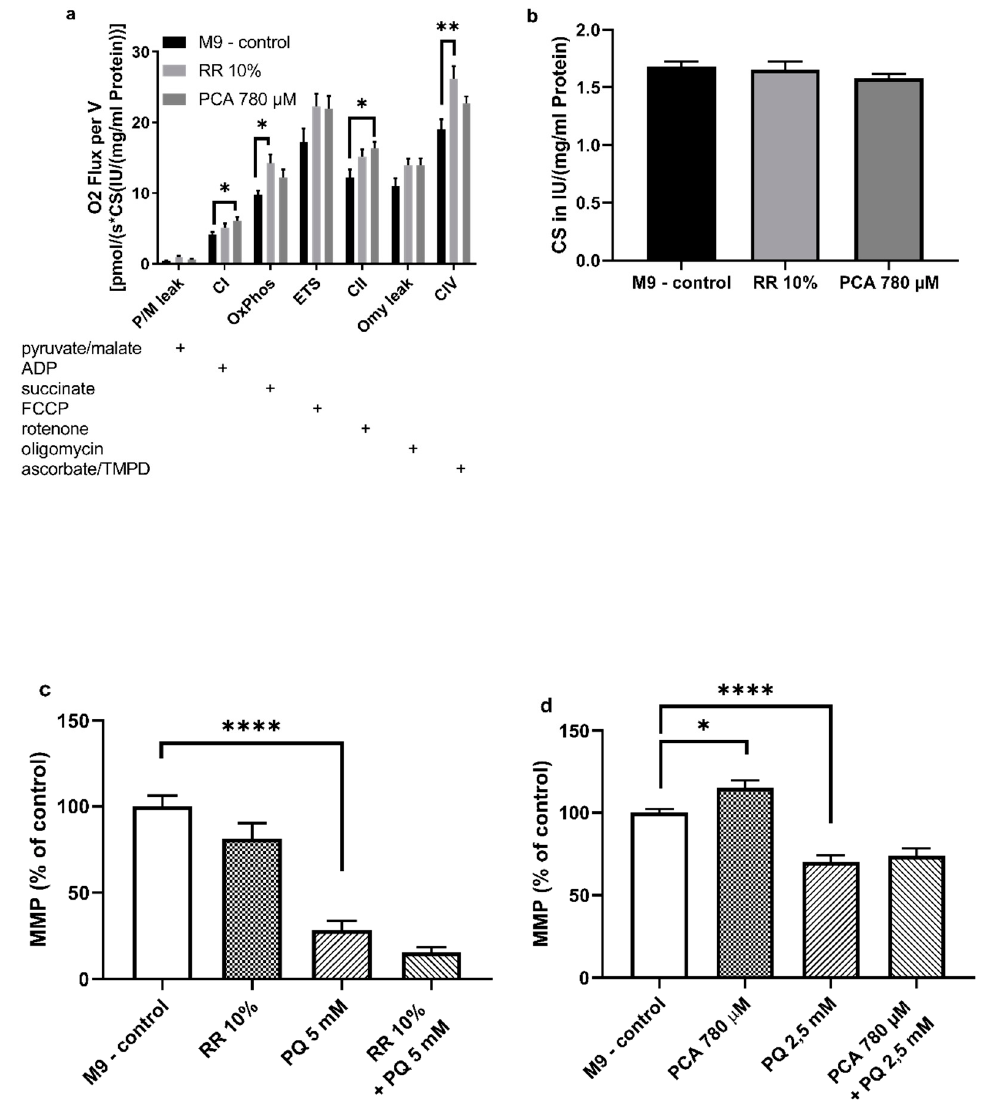
Figure 5. ( a ) Respiration of mitochondria isolated from Caenorhabditis elegans normalized to ( b ) citrate synthase activity in international units IU / (mg / mL protein). Activity of respiration complexes was measured using an O2k Oxygraph (Oroboros Instruments, Innsbruck, Austria). Addition of substances into the Oxygraph´s chambers is indicated with a plus sign. ( c , d ) Mitochondrial membrane potential ∆Ψ m assessed after addition of fluorescent dye Rhodamine 123 (Rh123) detected with a ClarioStar plate reader (BMG, Ortenberg, Germany); n = 7–13; mean ± SEM; one-way ANOVA with Tukey´s multiple comparison post-test; p * < 0.05, p ** < 0.01 and p **** < 0.0001.